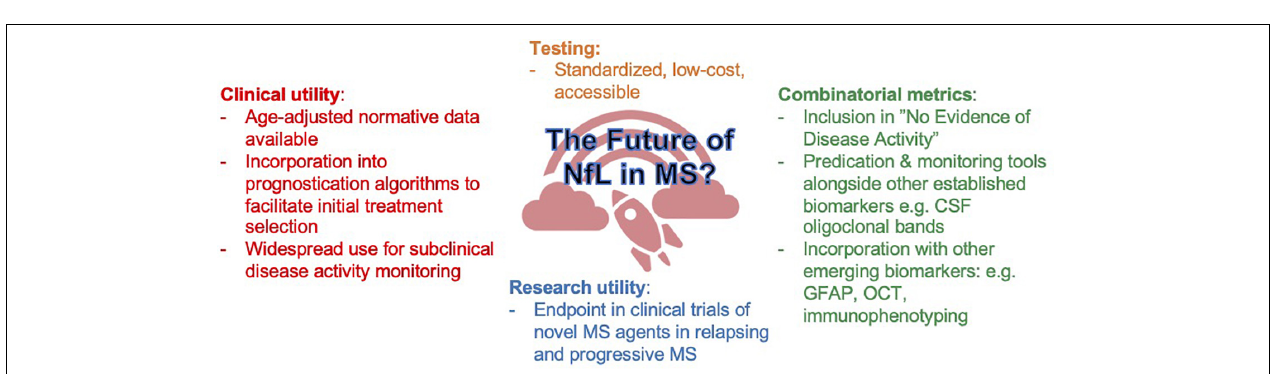
FIGURE 2 | Proposed algorithm for NfL monitoring in MS. *Clinical or MRI disease activity: New relapses, EDSS worsening, New/enlarging MRI lesion. **sNfL 95% age-dependent upper reference interval calculated on SiMOA HD1 instrument using Quanterix NF-lightTM (Hviid et al., 2020). ***The increase in sNfL from baseline that best denotes impending disease activity that should prompt further action is still to be determined. Preliminary data from 58 patients with MS followed every 3 months over 1 year suggests that a doubling of sNfL from baseline is associated with a 2.2 × relative risk of relapse (Thebault, Unpublished observation).